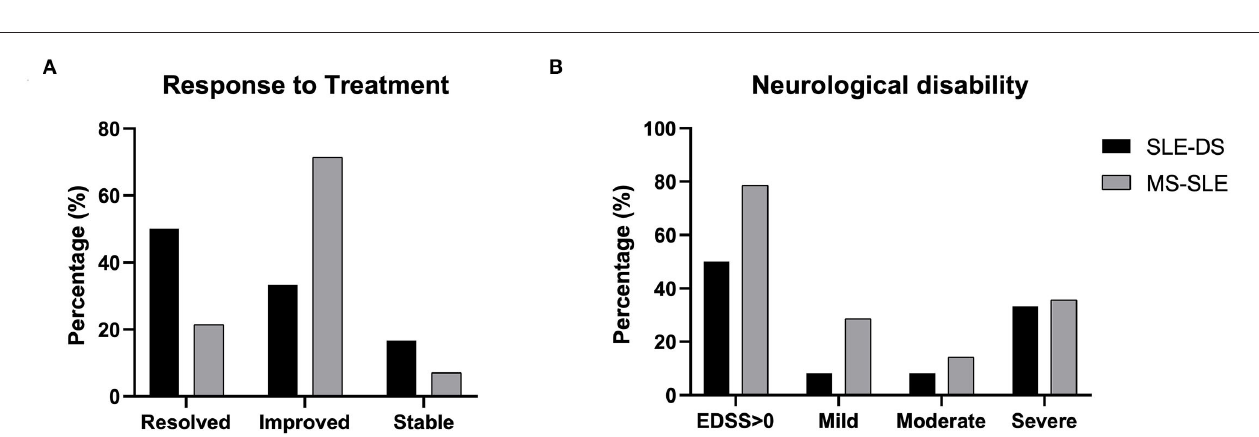
FIGURE 1 | Anatomical distribution of CNS lesions on brain, spinal and orbital MRI, in patients with SLE-demyelinating syndrome and patients with overlap SLE-MS. * p < 0.05, ** p < 0.01